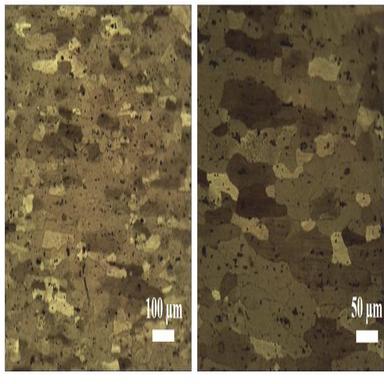
Optical microstructures of annealed AA6061 aluminum alloy before FSP treatment.